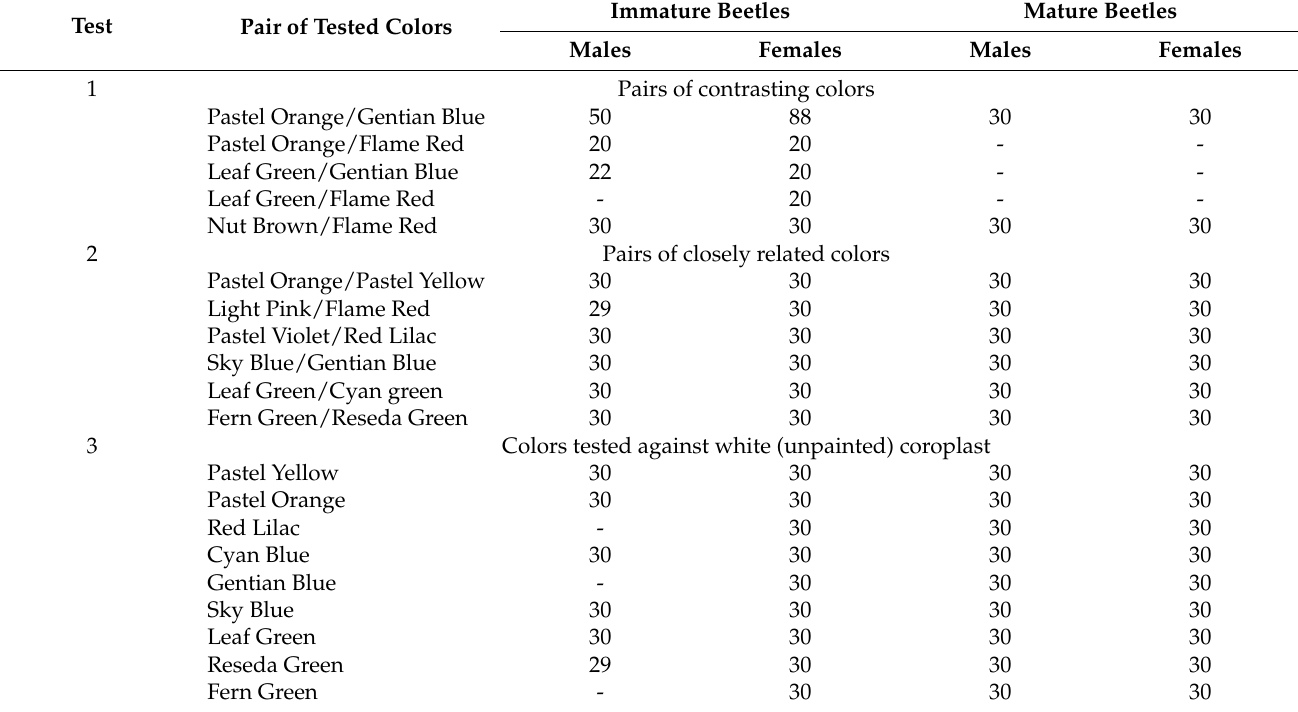
Table 2. Design of the laboratory tests and numbers of responding M. galloprovincialis beetles (non- responding individuals were excluded from the sample